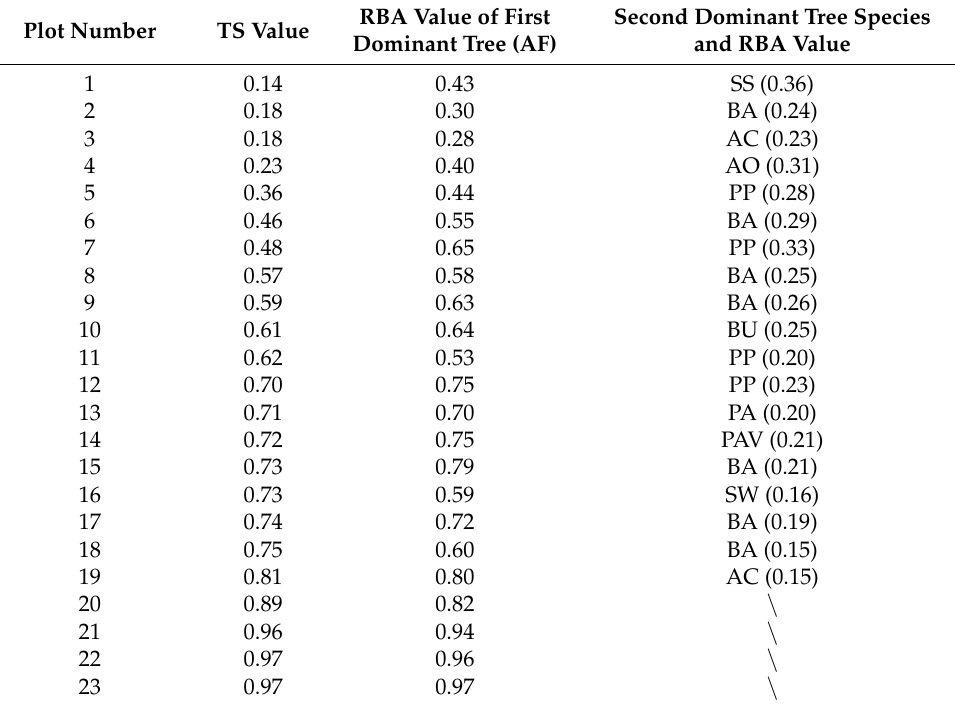
Table 1. Temporary stability (TS), relative basal area (RBA) of Abies faxoniana (AF), and the second dominant tree species in different AF-dominated plots. RBA Value of First Second Dominant Tree Species Plot Number TS Value Dominant Tree (AF) and RBA Value 1 0.14 0.43 SS (0.36)